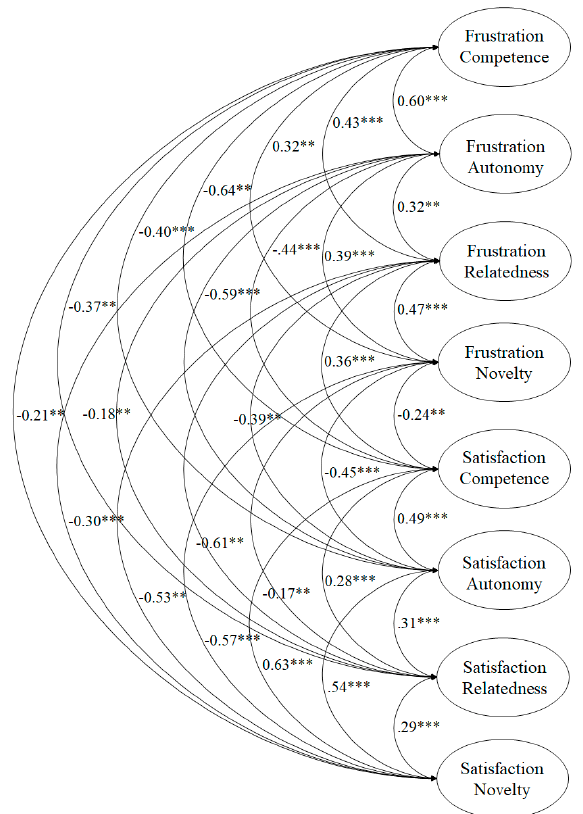
Figure 1. Confirmatory factor analysis of the Basic Psychological Needs Scale (BPNS).